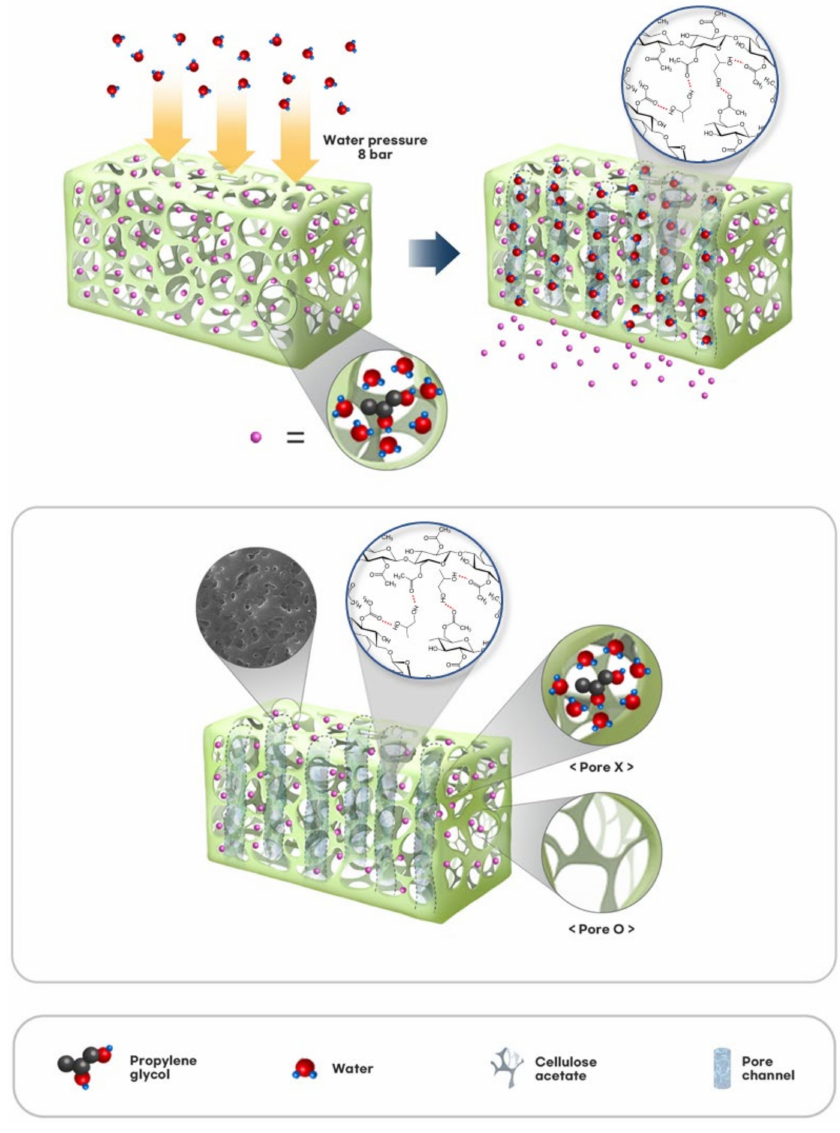
Figure 7. Schematic diagram of plasticized membrane and water treatment process. Table 2. Porosimetry data according to